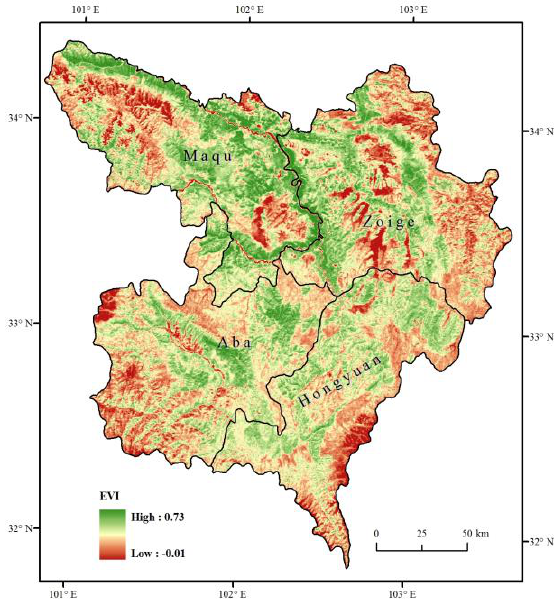
Figure 1. The spatial pattern of mean EVI from 2000 to